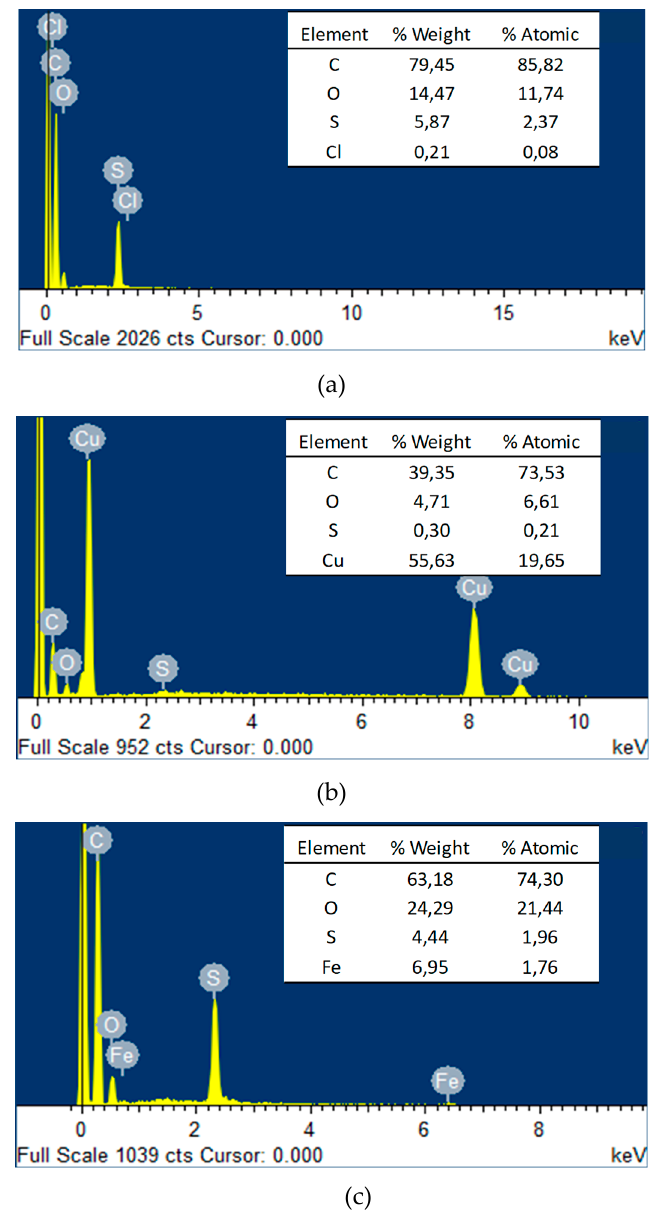
Figure 4. EDX analysis of membranes surface ( a ) PA-PSL; ( b ) PA+0.25Cu-PSL; ( c ) PA+0.25Fe-PSL.